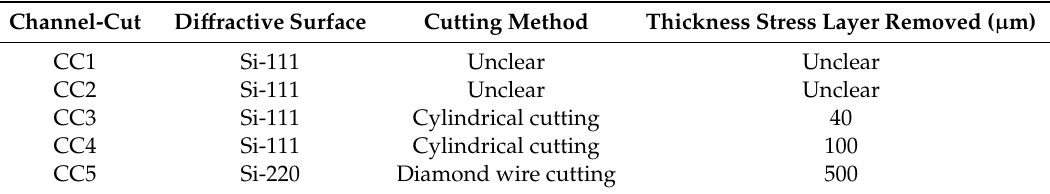
Table 1. Summary of five channel cut crystals’ preparation